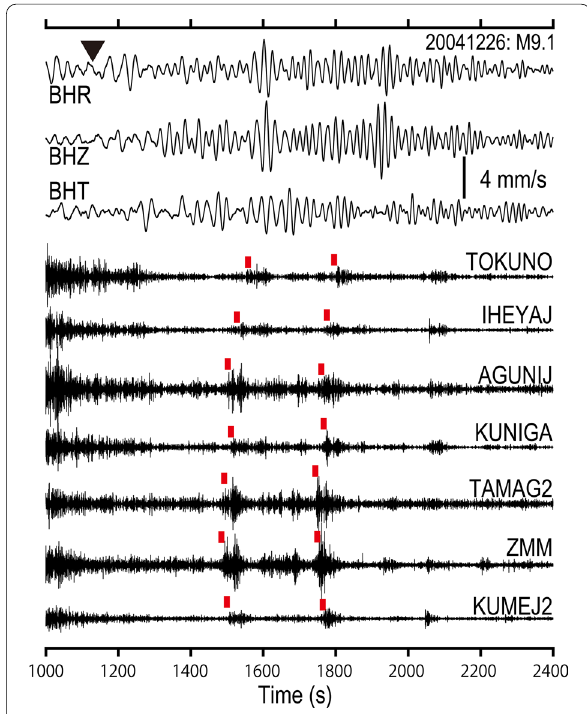
Fig. 3 Waveforms of the triggered LFEs observed in the Okinawa area. Broadband and short-period seismographs of the 2004 Sumatra earthquake. Upper part shows the instrumentally corrected broadband seismograph at ZMM. Zero time denotes the occurrence time of the earthquake. The black and white triangles denote the estimated arrival time of the Rayleigh and Love waves, respectively. The velocity of the Rayleigh and Love waves is assumed to be 4.0 km/s and 3.4 km/s, respectively. The thick vertical bar shows the scale of the broadband seismograph. Lower part shows the 2–4 Hz bandpass-filtered short-period seismograph of the N–S component. The triggered LFEs were recorded at several stations. The waveforms are plotted from southwestern stations to northeastern stations along the